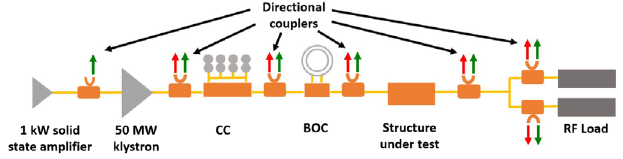
FIG. 8. XBOX2 block diagram.